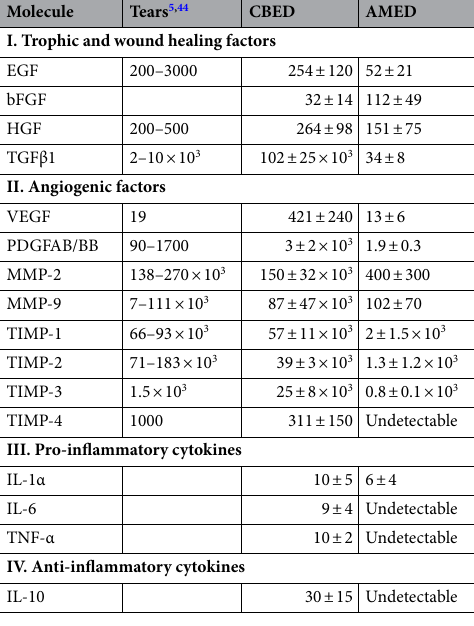
Table 1. GFs and cytokines concentrations in CBED and AMED. Results are presented as mean and SD (n = 10) in